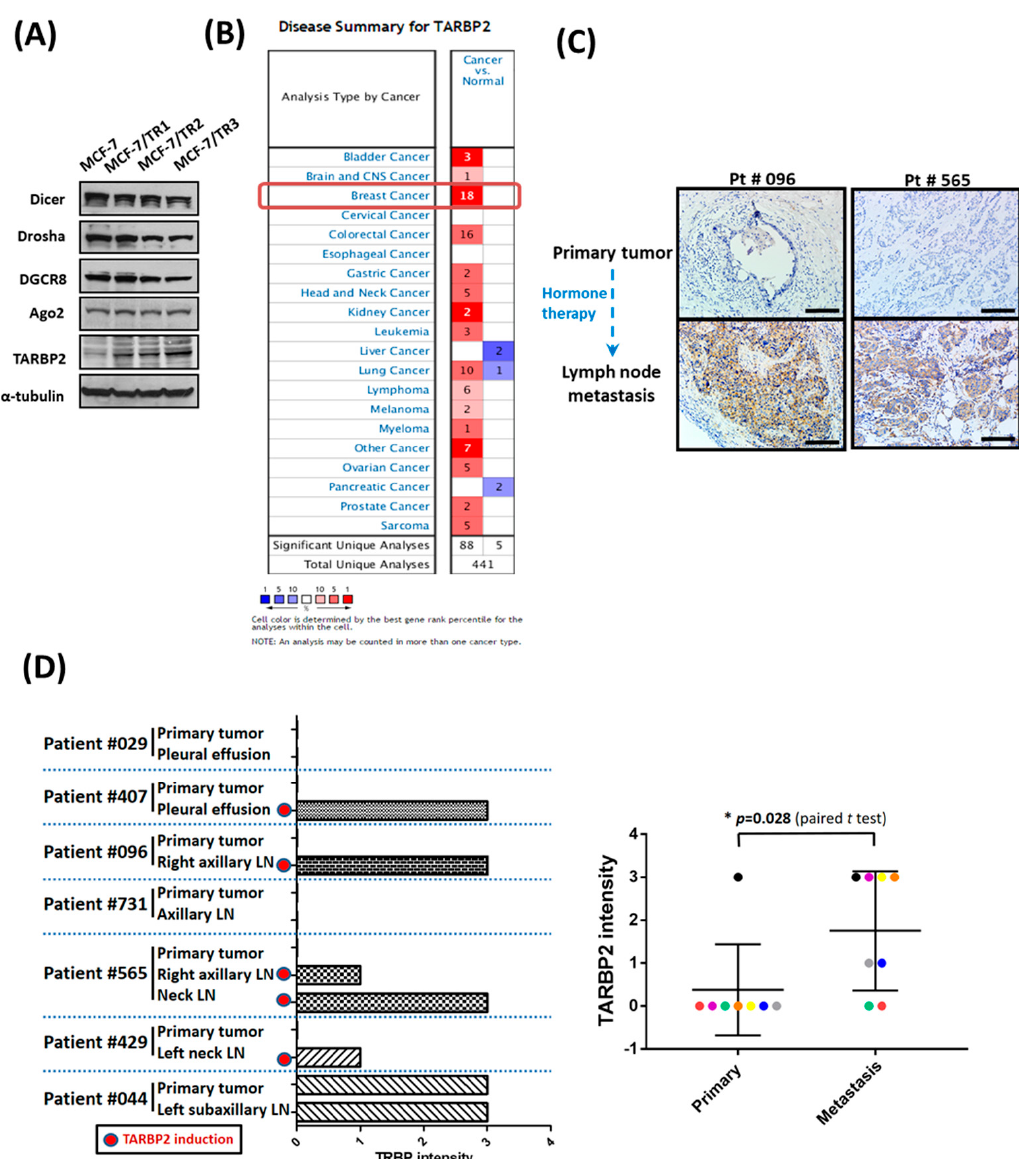
Figure 1. TARBP2 is overexpressed in hormone therapy resistant cells and breast cancer tissues. ( A ) Screening for the expression of different microRNA biogenesis factors in tamoxifen-sensitive cells (MCF-7) and tamoxifen-resistant cells (TR1, TR2, TR3). Cells were seeded in the plates and cultured until they reached 70–80% confluence; they were then collected to analyze the expression of TARBP2 by western blot. ( B ) The expression of TARBP2 was analyzed and downloaded using Oncomine (www.oncomine.org). Re-used from [22] ( C , D ) Association of TARBP2 expression and hormone therapy resistance in breast cancer tissues. Representative images of TARBP2 IHC in primary tumors and tumors in lymph nodes in cases of cancer recurrence ( C ). Scale Bar: 100 uM. Statistics of TARBP2 protein expression levels in primary tumors and metastatic tumor cells in in cases of cancer recurrence ( D ).